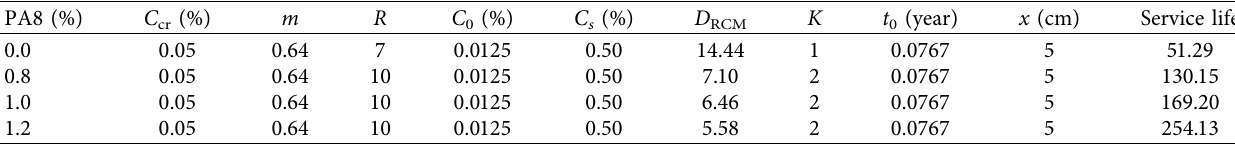
Figure 7: Microstructural characteristics of these concrete samples with different addition ration of PA8 (SEM images under different magnifications): (a) plain concrete without PA8, (b) concrete with 0.8% PA8 content, (c) concrete with 1.0% PA8 content, and (d) concrete with 1.2% PA8 content. Table 3: Calculation results of service life with different PA8 contents for concrete